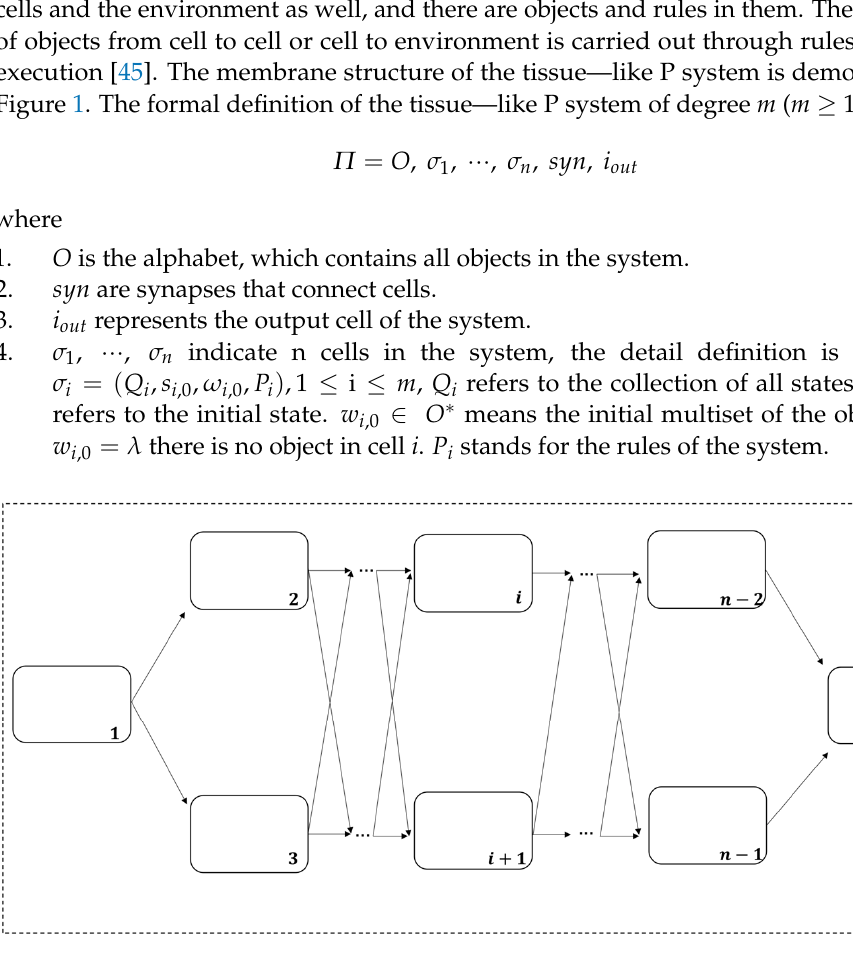
Figure 1. The basic membrane structure of the tissue—like P system.